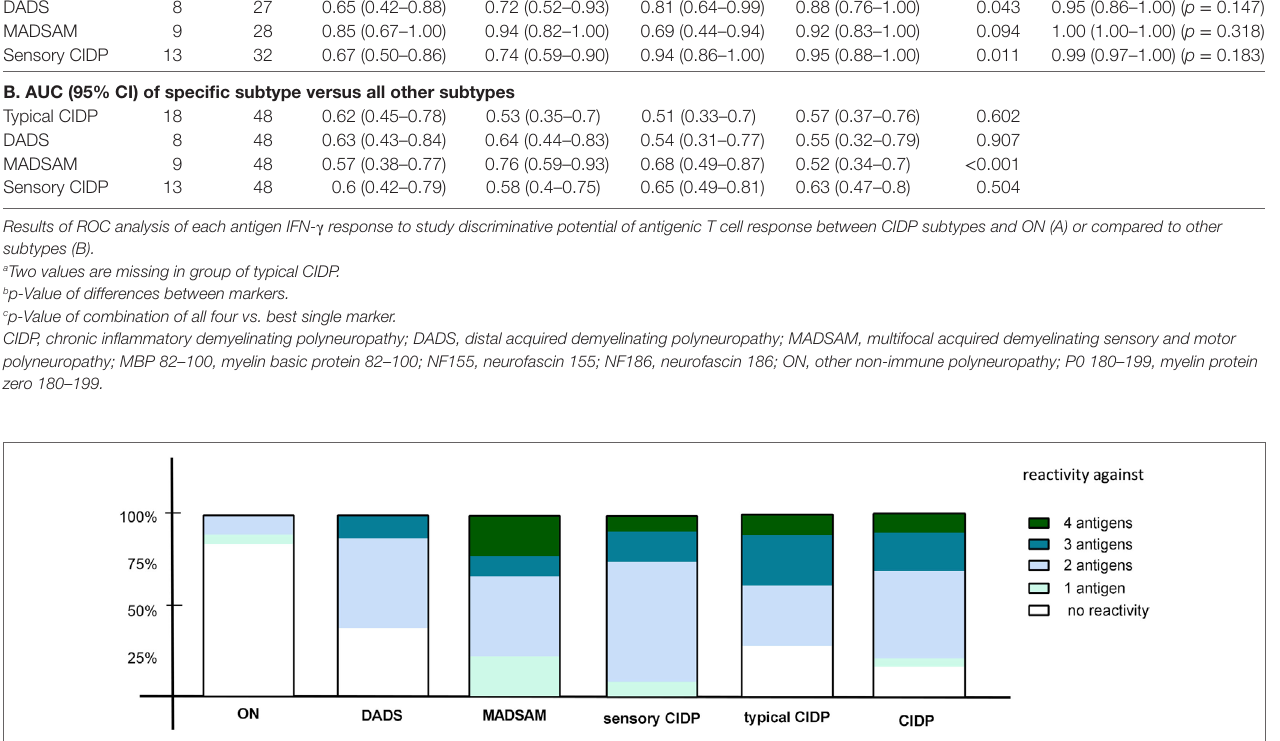
FigUre 3 | Diversity of antigenic response in chronic inflammatory demyelinating polyneuropathy (CIDP) and subtypes. The percentage of reactivity against four, three, two, one, or none of the tested antigens [neurofascin (NF) 155, NF186, P0 180–199, and MBP 82–100] is shown in other non-immune polyneuropathy (ON), demyelinating polyneuropathy (DADS), multifocal acquired demyelinating sensory and motor polyneuropathy (MADSAM), sensory, typical CIDP as well as all CIDP patients. The immune response against at least two antigens was most frequently in sensory CIDP (92.3%), MADSAM (77.7%), and typical CIDP (72.2%) compared to DADS (62.5%) and ON